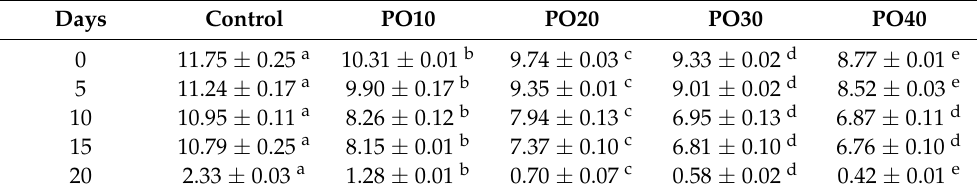
Table 6. Residual nitrite analysis of Pleurotus ostreatus (PO) pork sausages during storage (mg/kg). Days